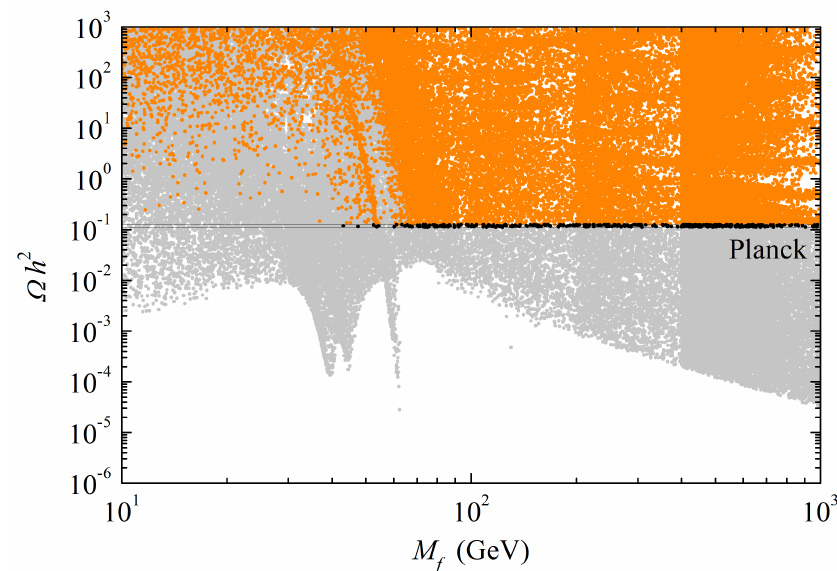
Figure 13 . Relic density Ω h 2 as a function of the fermion DM mass M f . We use the same colour code as in figure 9. However, the points in grey indicate an under abundance of relic density and/or are excluded by the LEP bounds on scalar masses [see eqs. (4.4) and discussion